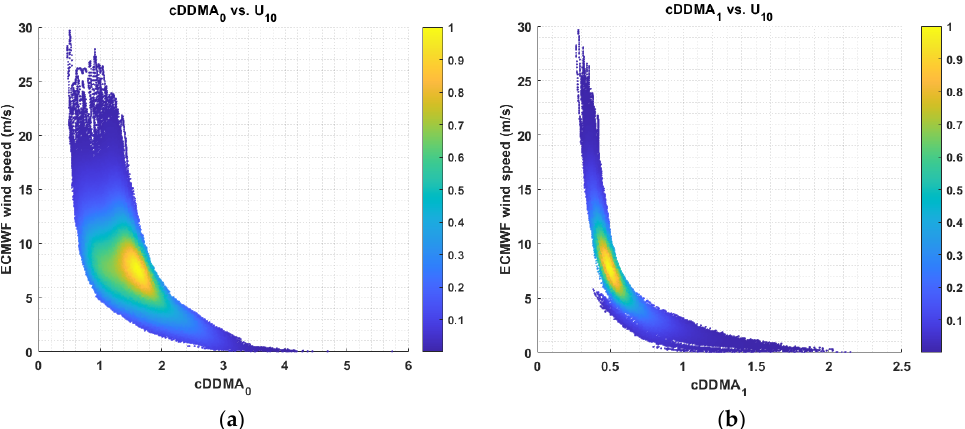
Figure 8. Scatter density plot of the cDDMA versus ECMWF wind speed before nadir gain correction ( a ) and after nadir gain correction ( b ).